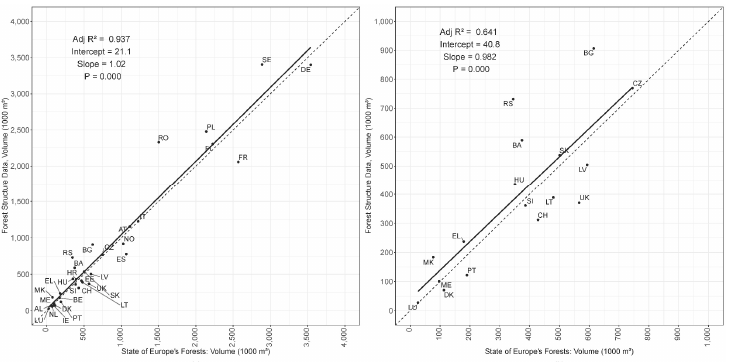
Figure A2. Comparison of the volume calculated from our Forest Structure Data versus the mean of the volumes for the period 2000 to 2010 as reported in State of Europe’s Forest 2015 [3] (Ind 1.2B Change in growing stock on forests). Forest Structure Data refers to the values calculated by combining the gap-filled maps with land cover information to calculate country totals (see Figure 7). In this case, underlying forest area estimations are based on CORINE land cover data, compared to Figure 11 where forest area estimations are based an MODIS land cover data as used in the study. Linear regression results R² (Adj R²), Intercept, Slope and p − Value (P) are shown. ( a ) Shows results when using all countries, irrespective if National Forest Inventory (NFI) data were available. ( b ) Shows the results only for countries where no NFI data were available. Country codes are: AL = Albania, AT = Austria, BA = Bosnia − Herzegovina*, BE = Belgium, BG = Bulgaria*, CZ = Czech Republic*, CH = Switzerland*, DE = Germany, DK = Denmark*, EE = Estonia, EL = Greece*, ES = Spain, FI = Finland, FR = France, HR = Croatia, HU = Hungary*, IE = Ireland, IT = Italy, LT = Lithuania*, LU = Luxemburg*, LV = Latvia*, ME = Montenegro*, MK = North Macedonia*, NL = Netherlands, NO = Norway, PL = Poland, PT = Portugal*, RO = Romania, RS = Serbia*, SE = Sweden, SI = Slovenia*, SK = Slovakia*, UK = United Kingdom*; Countries where no inventory data were present are marked with an asterisk.